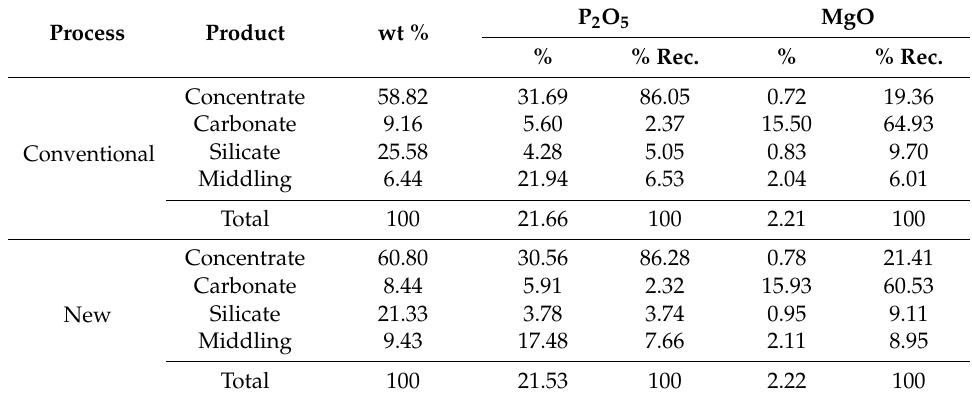
Table 6. Open circuit flotation results for the conventional process and the new process. Process